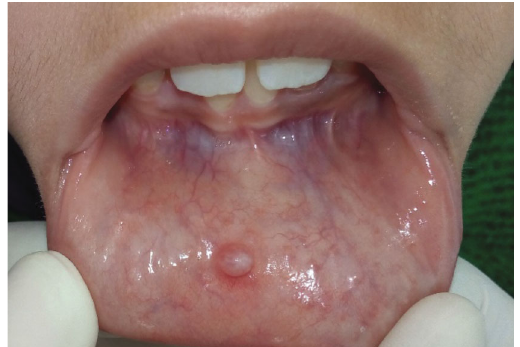
Figure 1: Clinical appearance of the mucocele in the lower